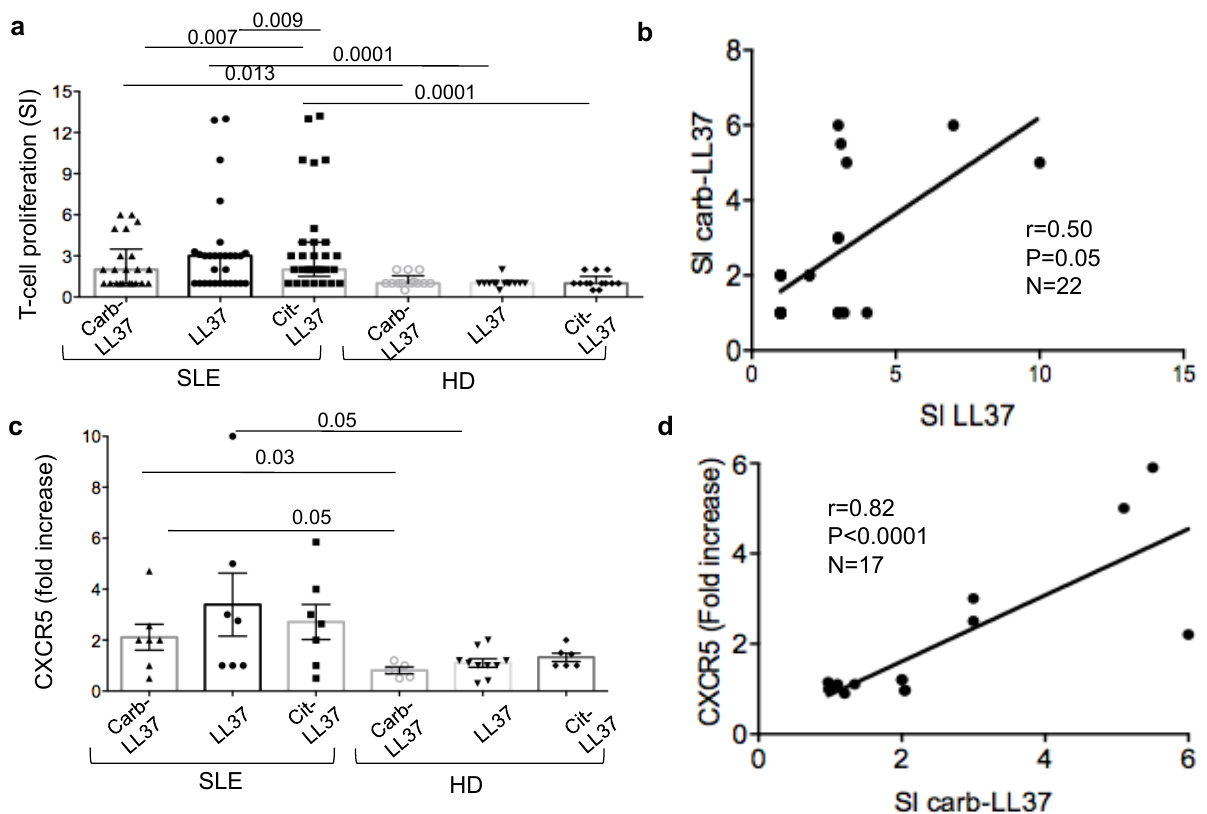
Figure 3. Carb-LL37 induces SLE T-cell proliferation. ( a ) Carb-, native and cit-LL37 induced SLE T-cell and HD T-cell proliferation, expressed as stimulation indexes (see Methods, SI). Horizontal bars represent the means, vertical bars standard errors of the mean, p -values by Wilcoxon’s test. SLE patients tested with carb-LL37 (N = 25), LL37 (N = 31), cit-LL37 (N = 31); HD = 14; ( b ) Proliferation (as SI) to carb-LL37 plotted against T-cell proliferation to native LL37 (SI LL37). Spearman’s r, significance p , sample size N, indicated. ( c ) CXCR5 expression (expressed as fold increase with respect to untreated T-cells) of BrdU + CD4 + T-cells, from SLE patients and HD, assessed by flow cytometry. Horizontal bars represent the means, vertical bars standard errors of the mean, p -values by Wilcoxon’s test. ( d ) CXCR5, expressed as fold increase with respect to expression in untreated cells, of CD4 T-cells from SLE patients or HD. Horizontal bars represent the means, vertical bars are standard errors of the mean, p -values by Wilcoxon’s